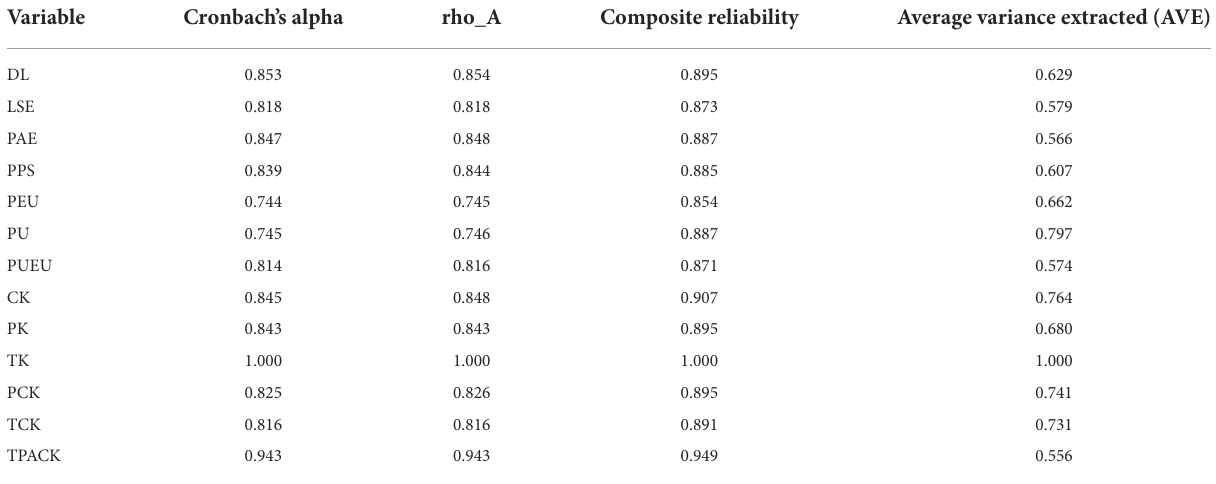
TABLE 8 Measurement model of PLS.